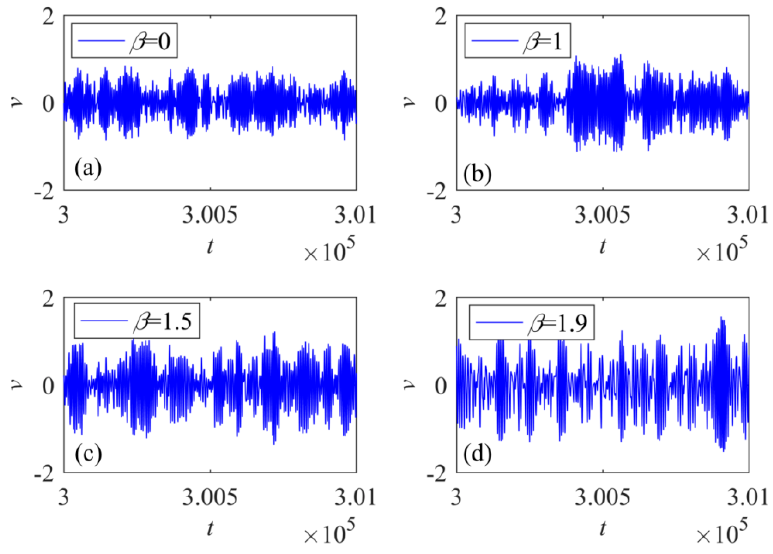
Figure 6. ( a ) Nonlinear restoring forces and ( b ) potential functions of the asymmetric MEHs for different values of quadratic coefficients.